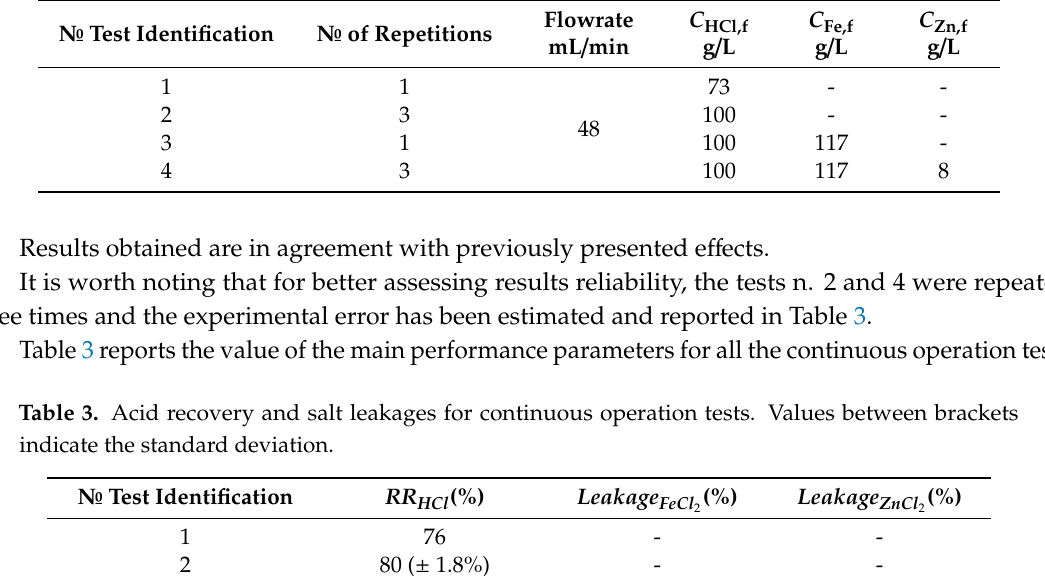
Table 2. Summary of tests performed with the continuous dialyzer. Flow rate refers to both di ff usate and dialysate. Concentration values reported indicate the initial feed concentration for the di ff erent species. Di ff usate solution consists of deionized water.